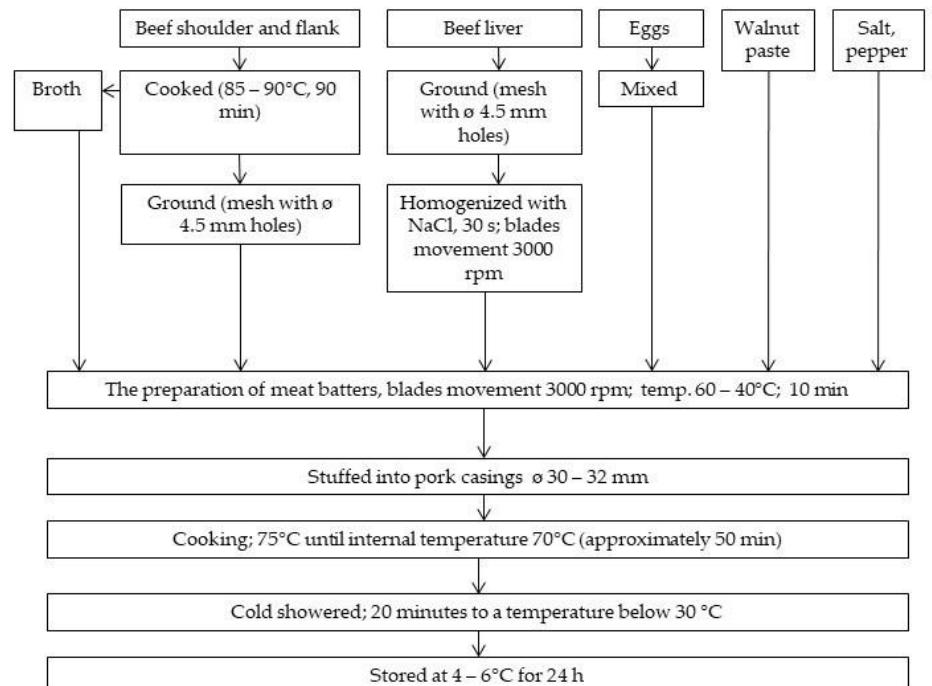
Figure 1. Technological scheme for the production of liver sausage with the addition of walnut paste .